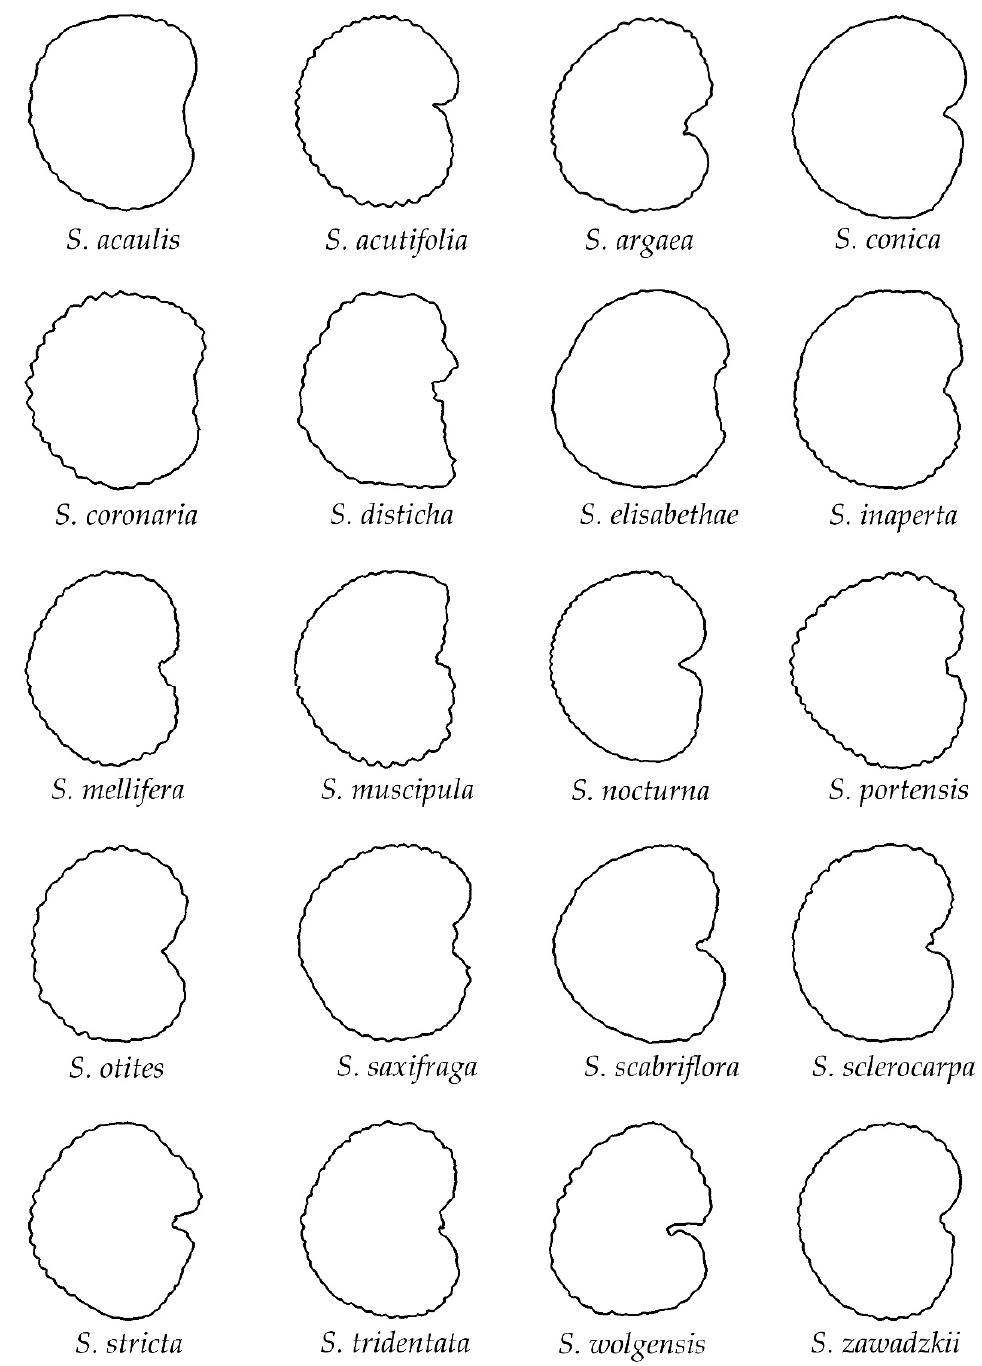
Figure 4. Silhouettes of the lateral views of Silene seeds belonging to the group of seeds with round tubercles.